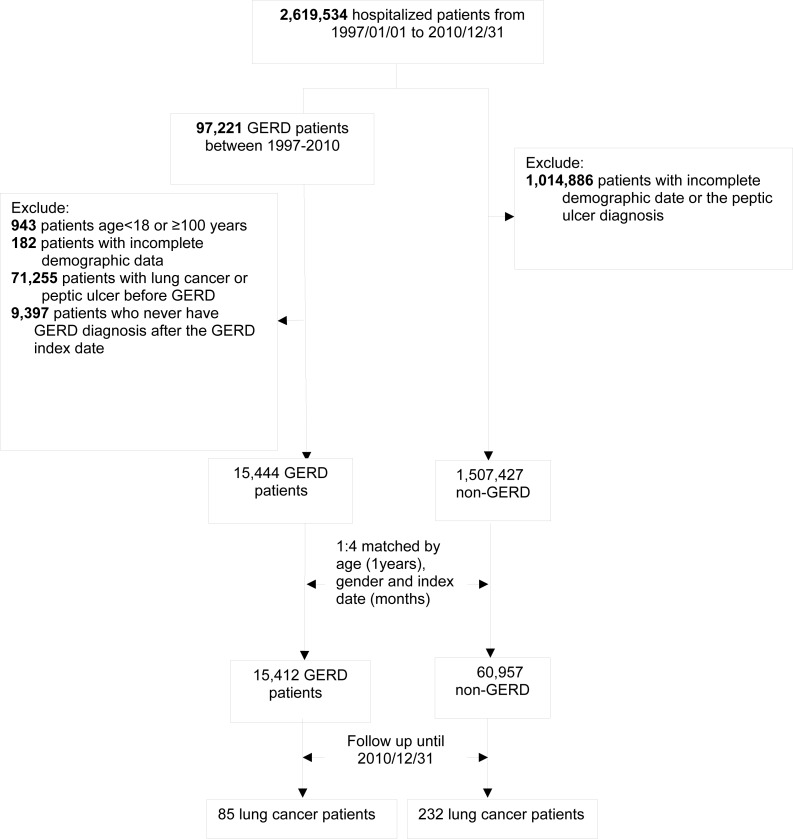
Study algorithm for patient enrollment.